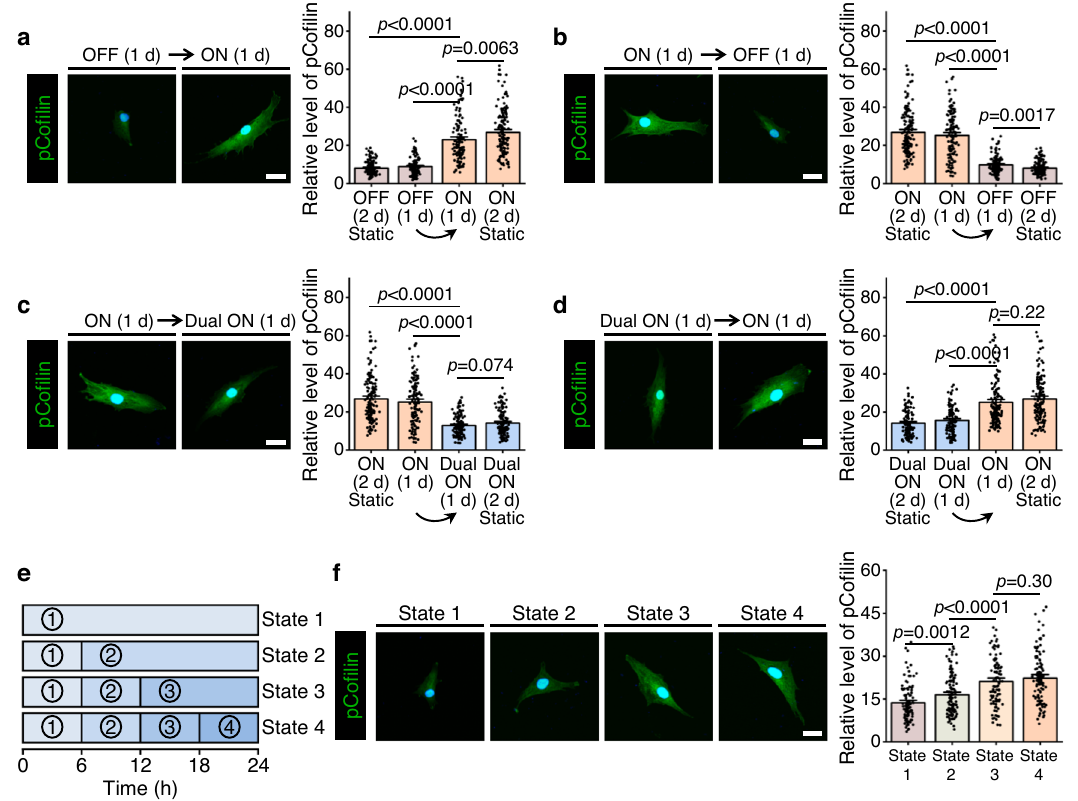
Fig. 7 | Programmable RGD/integrin and HAVDI/N-cadherin ligations regulate hMSCs mechanosensing by mediating co fi lin phosphorylation. a Left: Repre- sentative pCo fi lin images in hMSCs for state switching from “ OFF ” for initial 1 d to “ ON ” for subsequent 1 d. Right: Corresponding quanti fi cation of pCo fi lin levels based on the immunostaining (from left to right n = 122, 107, 131, 144 cells). Cells wereculturedoncontinuously “ OFF ” and “ ON ” substratesfor2dascontrolgroups. b Left:RepresentativepCo fi linimagesforstateswitchingfrom “ ON ” forinitial1dto “ OFF ” for subsequent 1 d. Right: Corresponding quanti fi cation of pCo fi lin levels based on the immunostaining (from left to right n = 144, 136, 112, 122 cells). Cells wereculturedoncontinuously “ OFF ” and “ ON ” substratesfor2dascontrolgroups. c Left:RepresentativepCo fi linimagesforstateswitchingfrom “ ON ” forinitial1dto “ DualON ” forsubsequent1d.Right:Correspondingquanti fi cationofpCo fi linlevels based on the immunostaining (from left to right n = 144, 136, 134, 127 cells). Cells